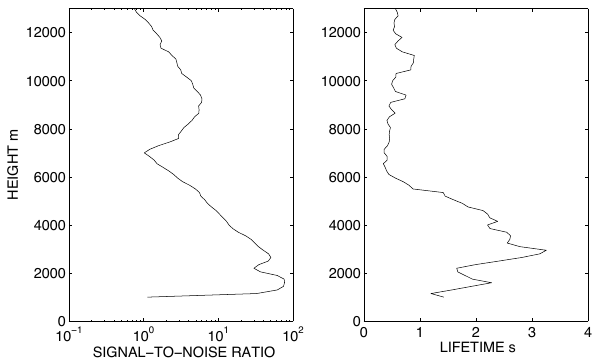
Fig. 6. Vertical profiles of the median values 23–25 January of the radar echo strength (signal-to-noise ratio) and diffraction pat- tern lifetime. See text for further